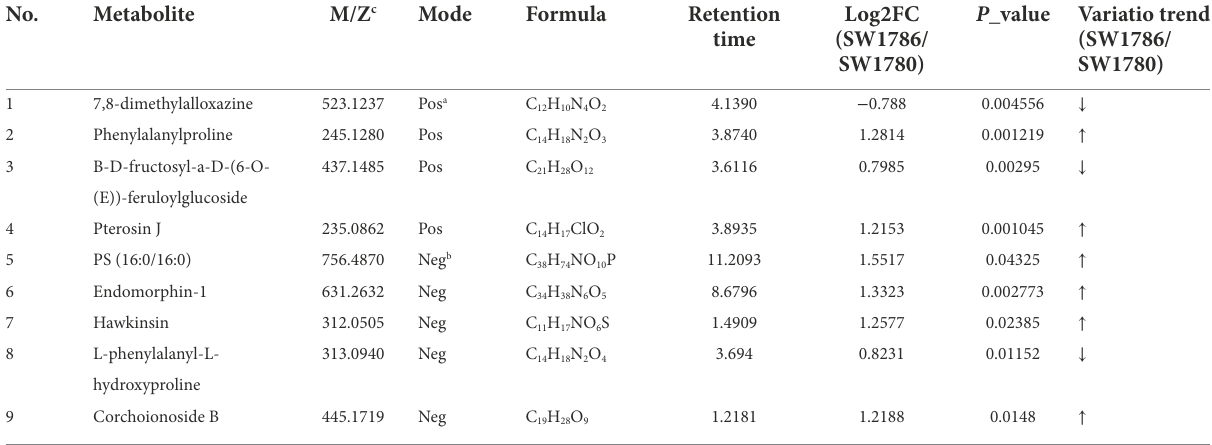
a Positive ion. b Negative ion. c Mass-to-charge